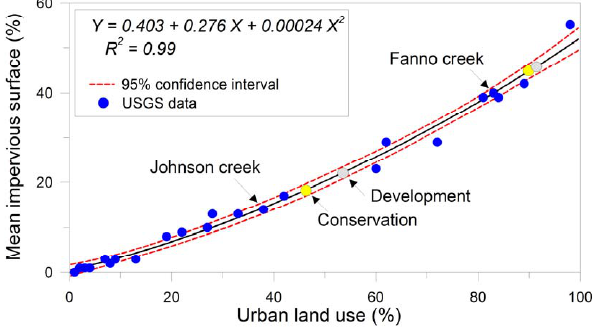
Fig. 3. Relation between urban land use (%) and mean impervious surface (%). Data are obtained from USGS Report 2006-5101-D (Waite et al., 2008, Table 7